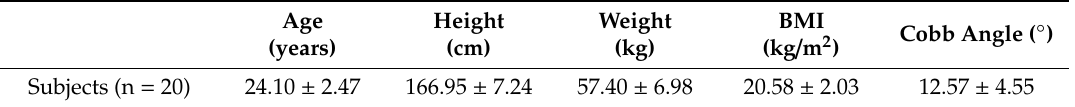
Table 2. Anthropometric data of the subjects (M ±